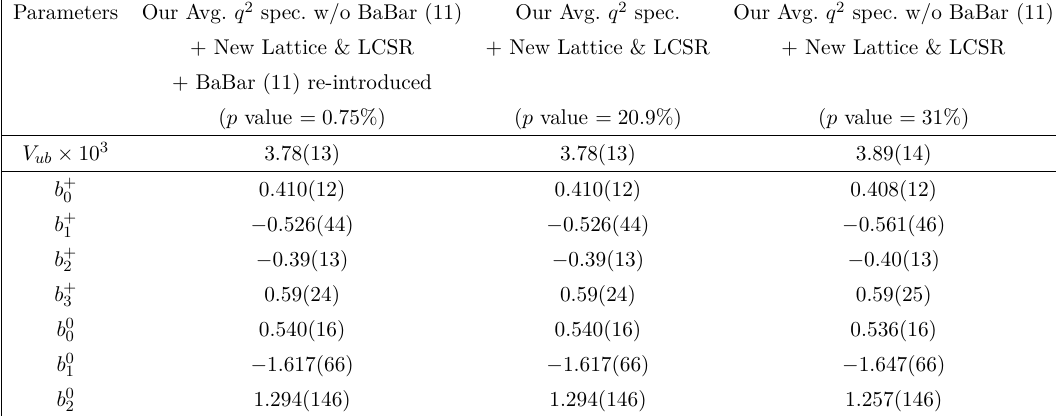
Table 6 . The extracted values of | V ub | and the other form-factor parameters using our average q 2 spectrum of the partial branching fractions and the new lattice and LCSR inputs. Fourth column uses the avg. q 2 spectrum without BaBar (11) data (last column of table 1), while the third uses that from the third column of table 1 (with all data). In the second column of this table, we repeat the last fit after recombining BaBar (11) data